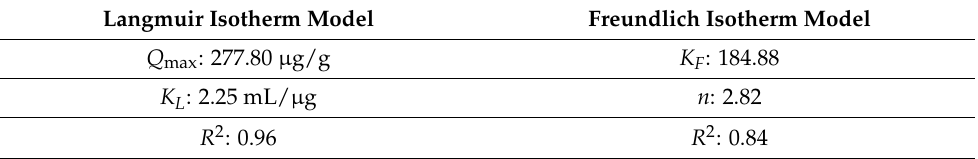
Table 2. Parameters of Langmuir and Freundlich